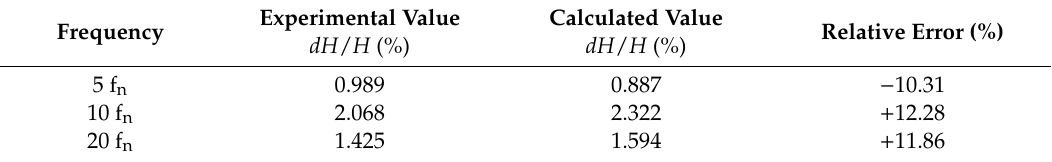
Table 4. Comparison between calculation and test results of pressure fluctuation in the bladeless region.